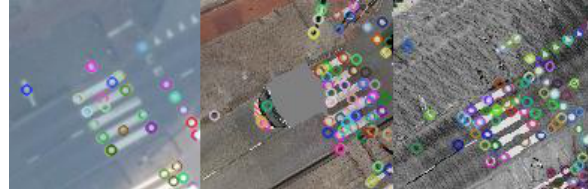
Figure 6 KAZE keypoints detected in aerial image (left), panoramic image (centre) and MLS intensity image (right)